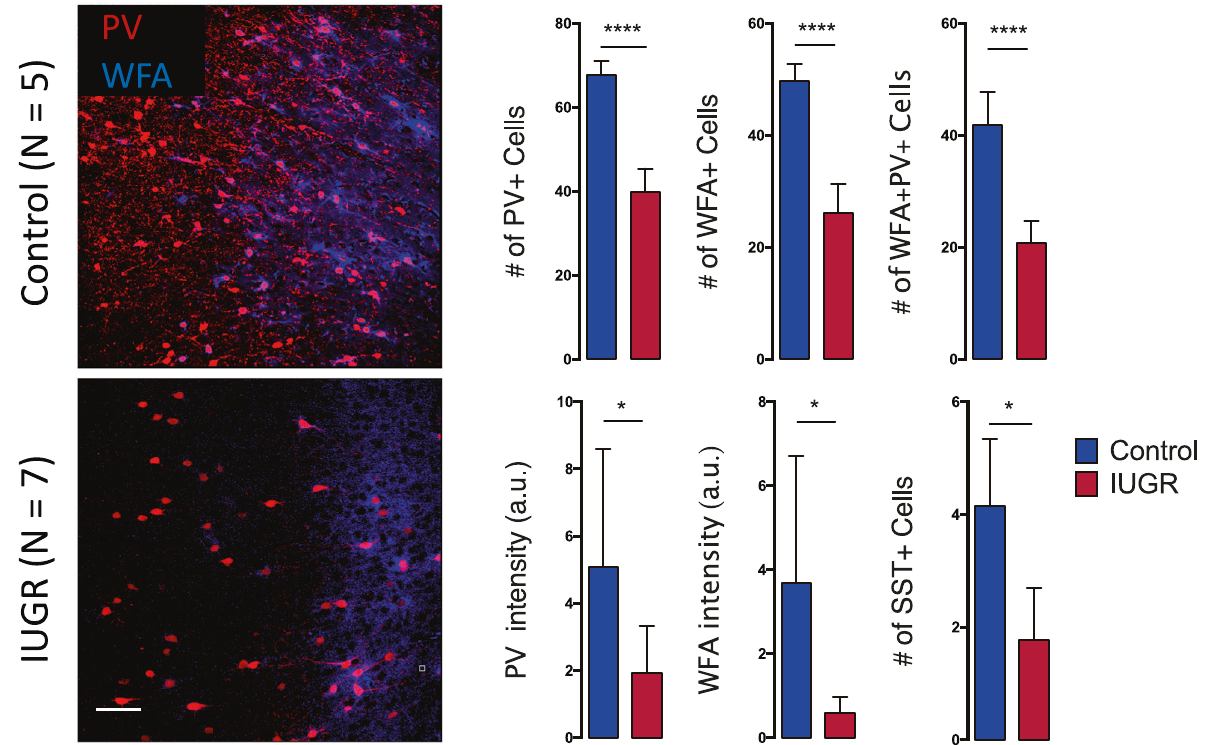
Fig. 2 Decreased PV, PNN, and SST in the low protein induced IUGR offspring at P35. Images for PV, WFA (label for PNN) and WFA-positive PVI in both control ( n = 5) and IUGR ( n = 7) groups. IUGR leads to signi fi cant decrease in PV + cells, PV intensity (a.u.), number of WFA + cells, WFA intensity (a.u.), number of WFA + PV + cells, and SST + cells in the ACC as compared to controls. Results are mean ± STD, * p = 0.05, ** p < 0.01, **** p < 0.0001 Control vs IUGR. Scale bar: 60 μ m.